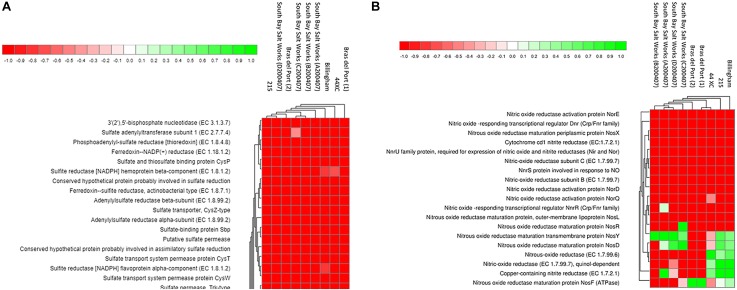
Heatmaps generated from the MG-RAST pipeline SEED Subsystems analysis of three brines collected during this study (44XC, Billingham and 215), and six other publicly available hypersaline brines, for denitrification (A) and inorganic sulfate metabolism (B) pathways. Data was normalized using DESeq package built into MG-RAST. Brightest green represents the most abundant features (1) and red, the least abundant (−1). For more detail on the generation of these plots, see Wilke et al. (2016).